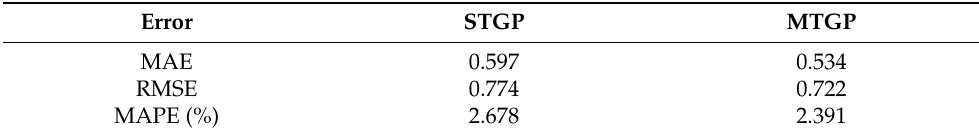
Table 6. Error results of STGP and MTGP for the extreme situation.